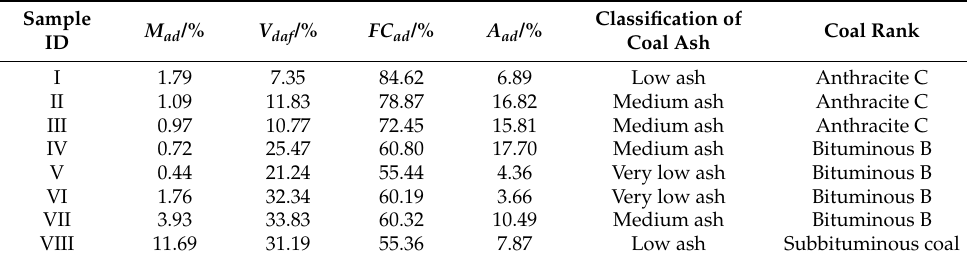
Table 1. Results of proximate analysis for 8